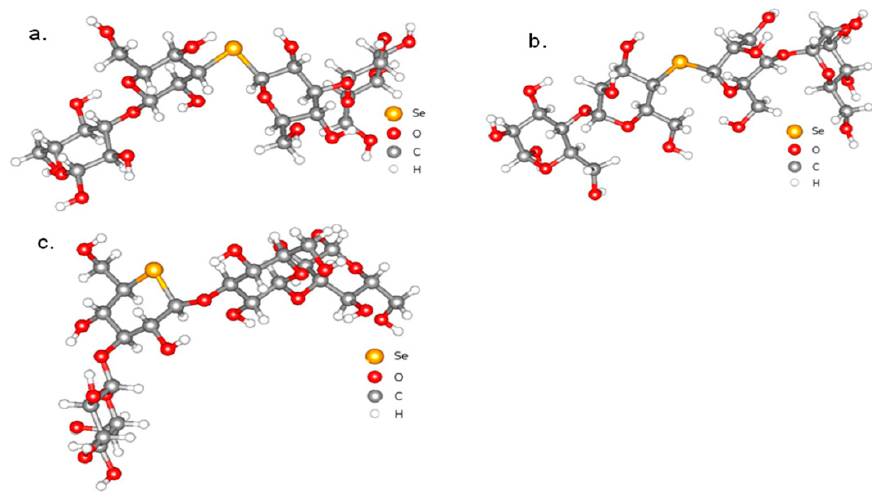
Figure 9. The hypothetical local structures around Se in Se-polysaccharide [39]: ( a ) 1,3-Se- β -D-glycosidic bond in glucan chain, ( b ) 1,4-Se- α -D-glycosidic bond in mannan chain, and ( c ) Se in glucopyranose ring.